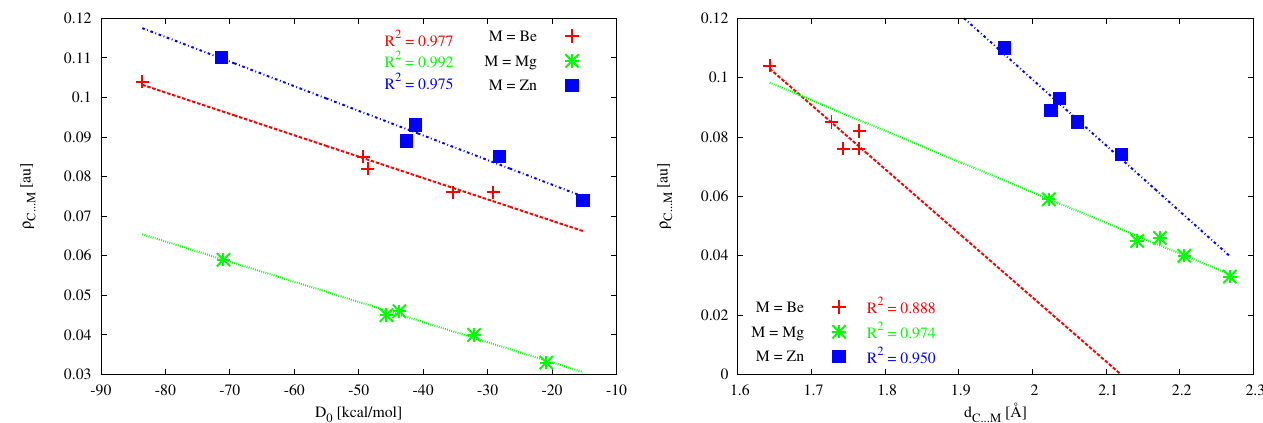
Figure 14. The relationships between the electron density at the bond critical point of the C · · · M interaction ( ρ C ··· M ) and either the dimer dissociation energy ( left ) or the C · · · M distance ( right ) determined for the dimers in Table